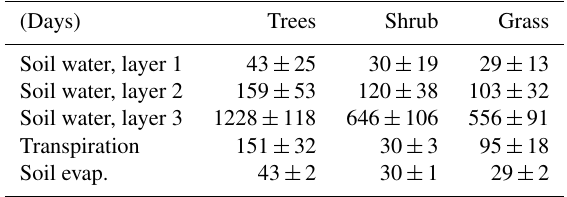
Table 3. Ages in soil water (three layers), transpiration, interception evaporation and soil evaporation (days) under trees, shrub and grass. (Days) Trees Shrub